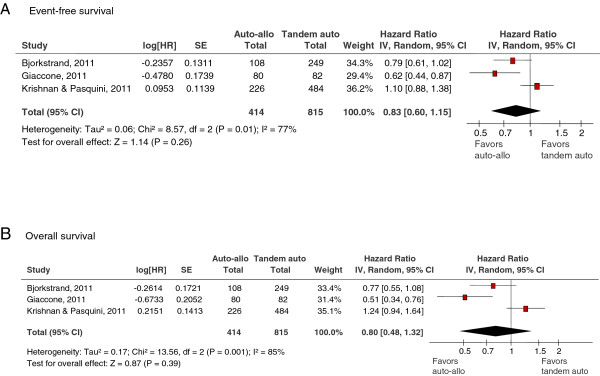
A and 3B: Forest plot for event-free survival according to intent-to-treat analysis (A) and overall survival (B). The summary estimate (hazard ratio) from individual studies is indicated by rectangles with lines representing the 95% confidence intervals (CIs). The summary pooled estimate from all studies is represented by the diamond and the stretch of the diamond indicates the corresponding 95% CI.